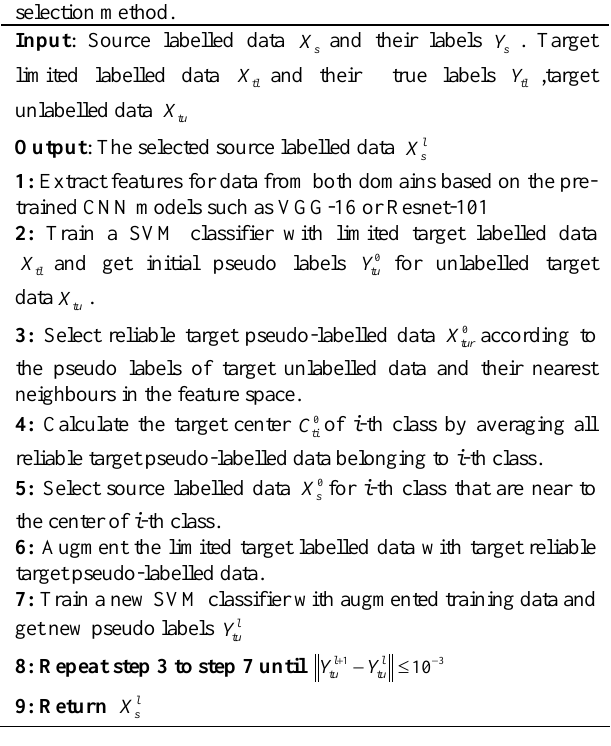
Algorithm 1 The process of the proposed source sample selection